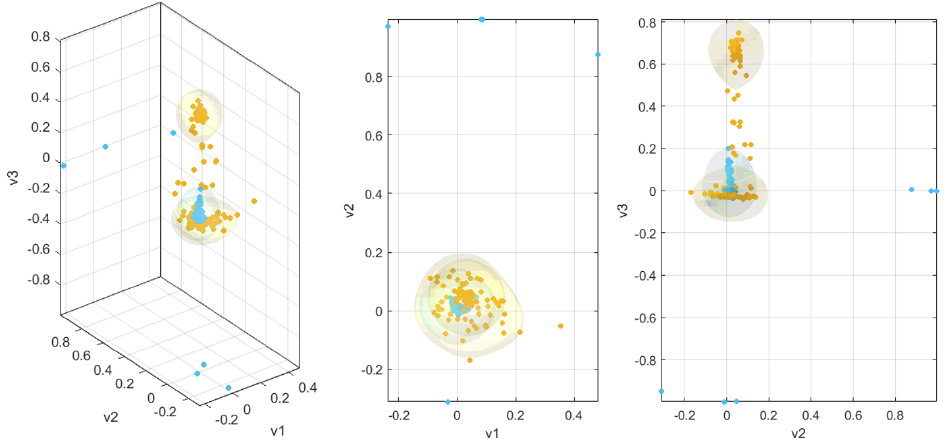
Figure 14. Representation of health services emergencies related to traffic accidents in blue, and with traumatism events in yellow. We observe that most of the traffic accidents are related to traumatism reported, but not all the traumatism events are related to